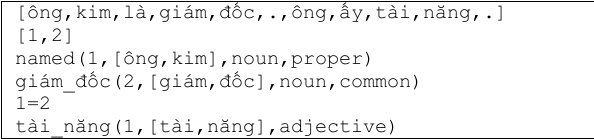
Figure 21. The DRS with main predicates of two- sentences Vietnamese paragraph “Ông Kim là giám đốc. Ông ấy tài năng.”